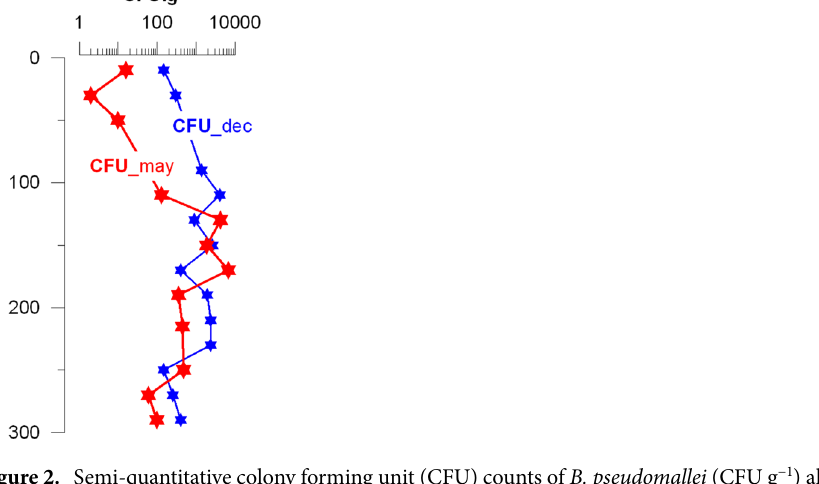
Figure 2. Semi-quantitative colony forming unit (CFU) counts of B. pseudomallei (CFU g −1 ) along the 300-cm deep profile, in May (CFU_may) and December (CFU_dec) 2018. B. pseudomallei was not detected at 80-cm and 230-cm in May, and at 50-cm in December.